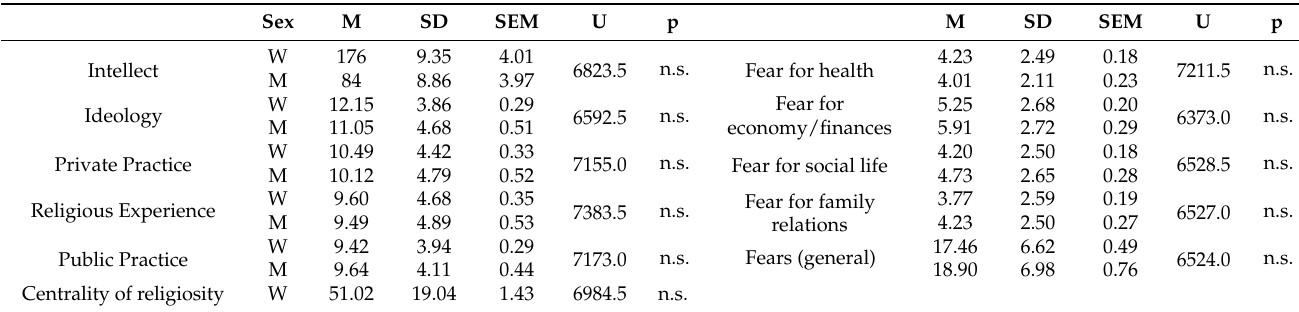
Table 2. Descriptive statistics and the significance of differences in the intensity of studied variables in men and women (df =